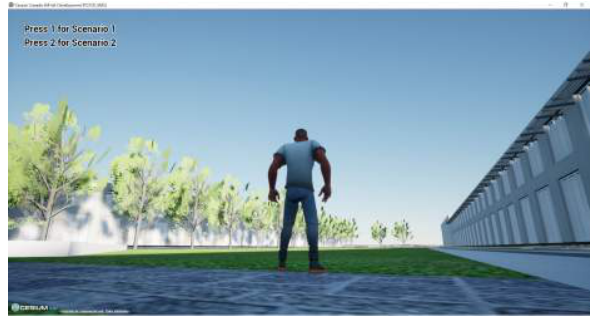
Figure 10. Area with existing